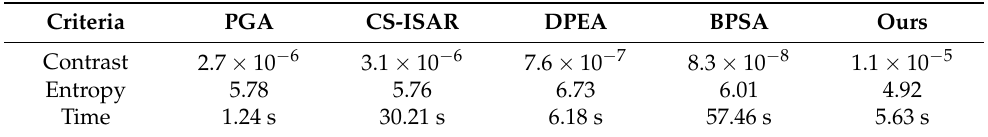
Table 3. Simulated trajectory error parameters.